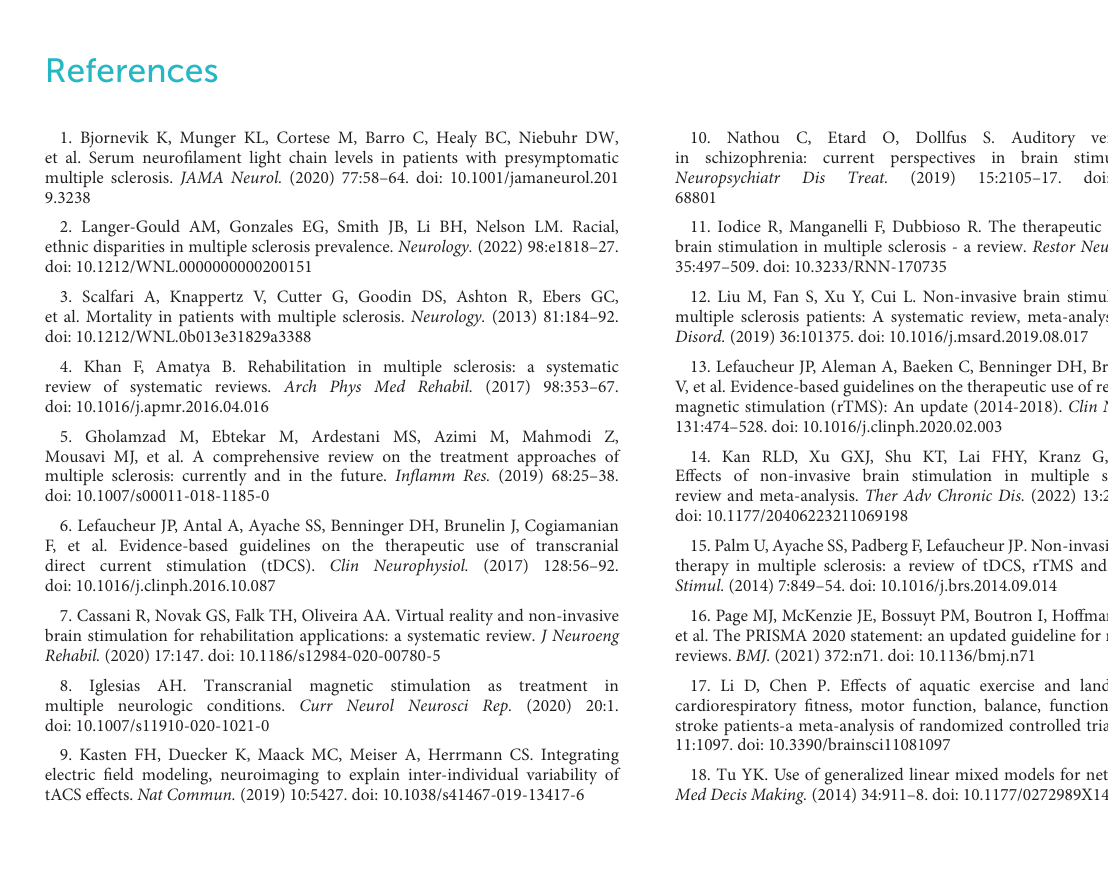
figure. ∗ Very low quality of evidence. SUPPLEMENTARYTABLE4 League table of comparisons the follow-up effect between all interventions for outcome parameters: (A) fatigue, (B) spasticity. The certainty of the evidence (according to GRADE) was incorporated in this figure. ∗ Very low quality of evidence. SUPPLEMENTARYTABLE5 Number of studies and patients involved in each neurological